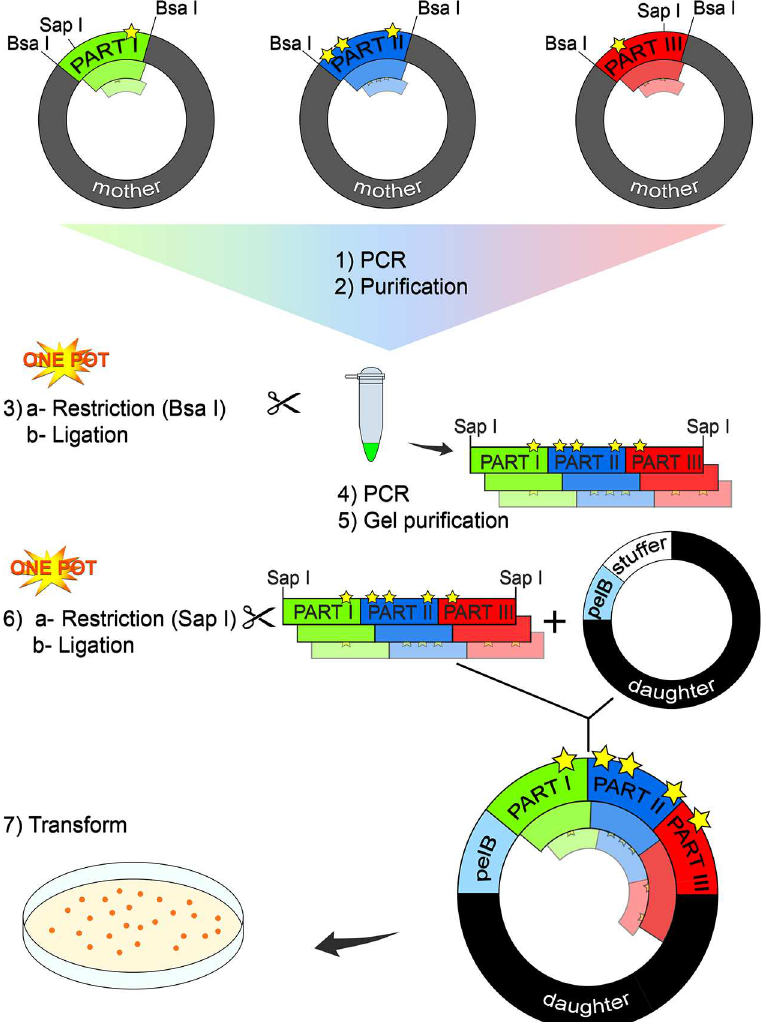
Fig 2. Facile reassemblyof individually mutated gene parts. The Cal-A gene was obtained as three separateparts in DNA2.0 mother vectors. In this method, the parts can be mutated independently as appropriate for each part (Table 1, yellow stars represent illustrative mutations). As a proof of concept to demonstrate the versatility of the method, NDT librarieswere generatedfor parts 1 and 3, and part 2 was randomly mutated. The parts (both mutated and wild-type) were then amplifiedby PCR reactions. They were then purified(steps 1, 2 and S3 Fig) for assembly into a numberamong the possiblecombinations of mutated parts (see Table 1 for chosen combinations), in a one-pot restriction-ligationreaction using Bsa I (3). The library of assembled genes was PCR amplifiedand gel purified(4, 5 and S4 Fig). Each amplifiedlibrary was